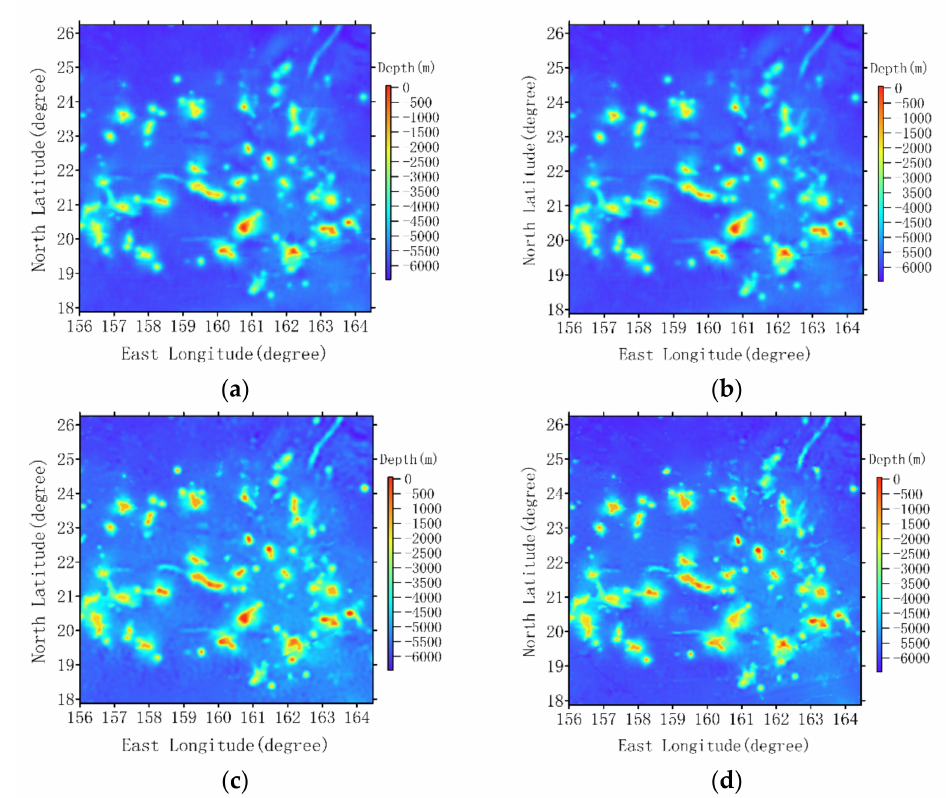
Figure 8. Seafloor topographic models with 1 (cid:48) × 1 (cid:48) resolution. ( a ) ST_TCFWO model which was inverted using the GR_TCFWO model. ( b ) ST_KR model was estimated using the GR_KR model. ( c ) ETOPO1 model from NGDC. ( d ) V19.1 model from